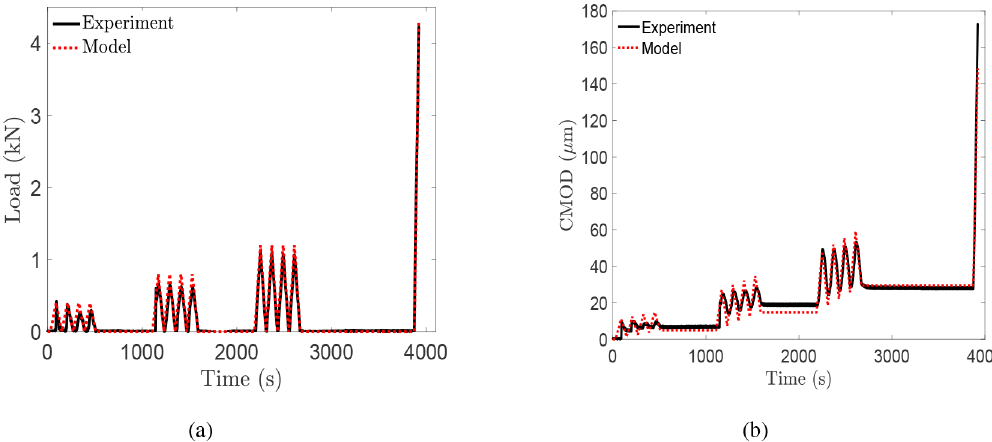
Figure 10. Experimental and model results for RP17. (a) Load at the crack mouth; see Fig. 1. (b) CMOD–time